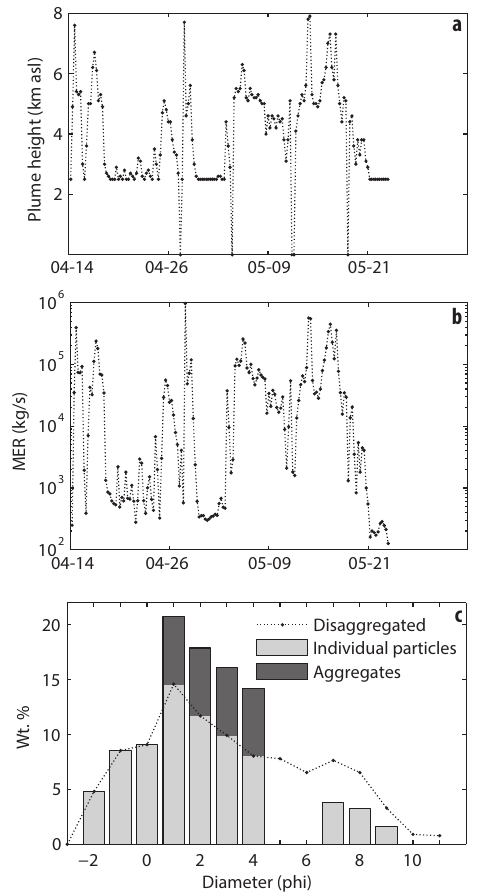
Figure 6. ESP for the Eyjafjallajökull LLOES; (a) 6h interval mea- surements of plume height for the period 14 April–21 May 2010 (Arason et al., 2011); (b) corresponding MER for the same period based on wind conditions extracted from the ERA-Interim database and the method of Degruyter and Bonadonna (2012); (c) disaggre- gated and aggregated TGSD as inferred by Bonadonna et al. (2011). See caption of Fig. 4 for explanation of symbols.